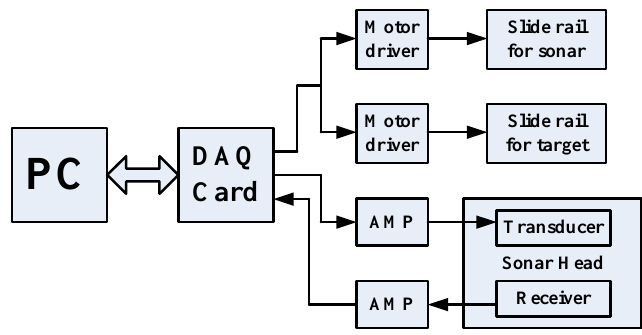
Figure 7. The control diagram of the experimental